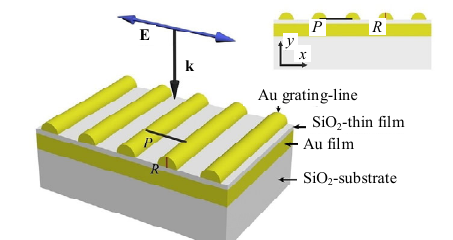
Fig. 1 3D geometric structure of the 1D grating composite structure. From top to bottom, the components consist of the 1D gold semi-cylinder grating, silicon dioxide thin film, gold film, and silicon dioxide substrate (the black arrow indicates the direction of propagation of the incident light, the blue arrow indicates the polarization direction, and the black and red lines are the period and radius,